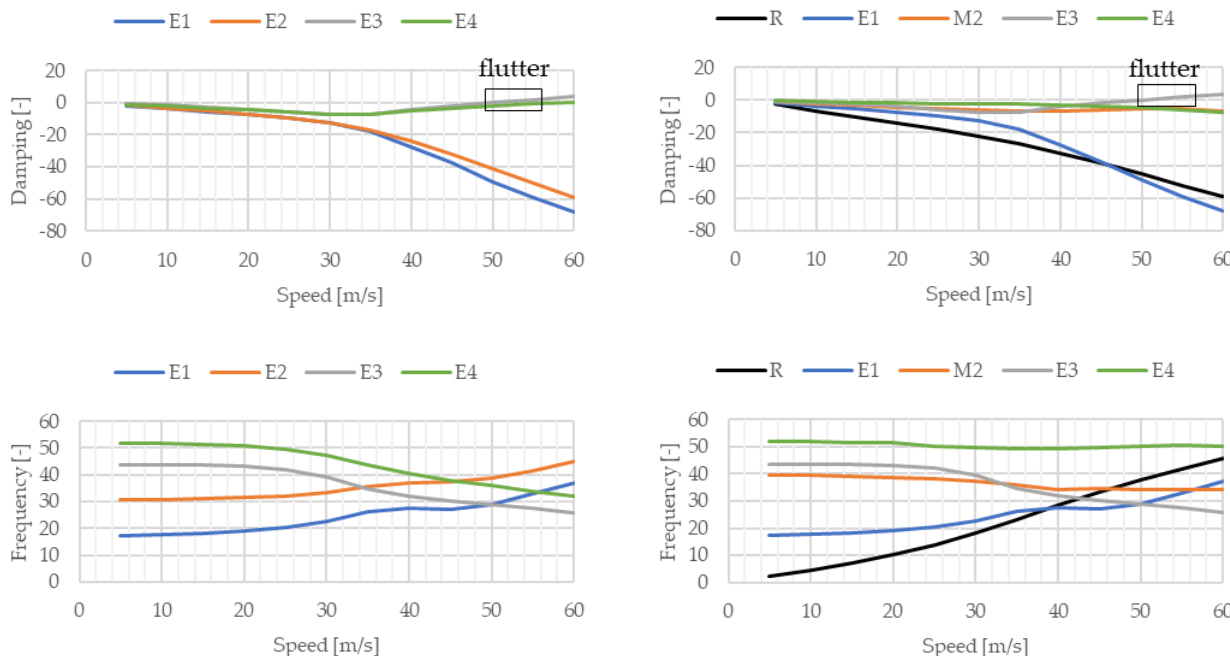
Figure 17. Flutter analysis results for the box-wing architecture under clamped ( left ) and free sym- metric flight ( right )